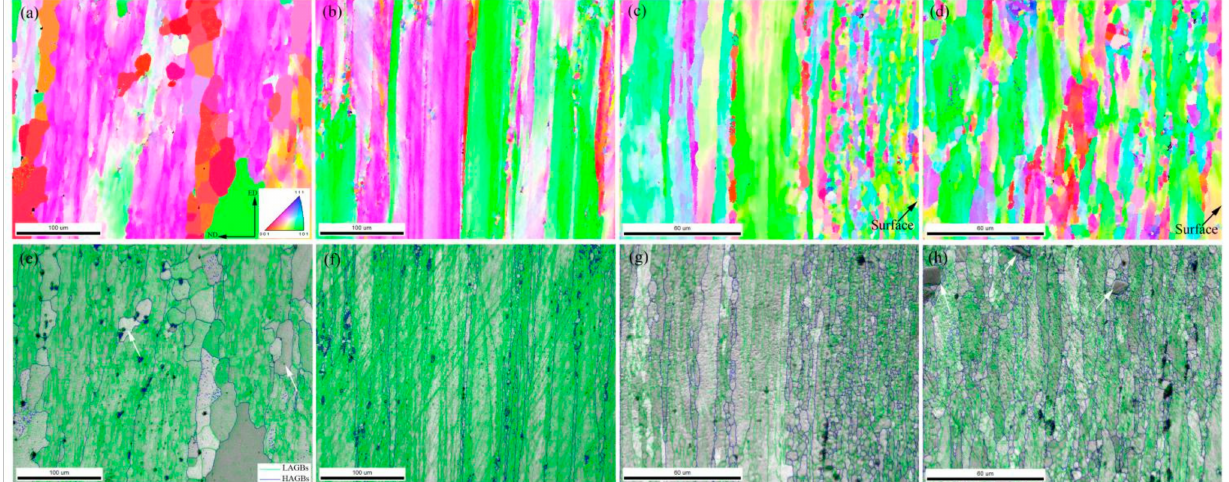
Figure 5. Grain orientation and grain boundary distribution maps of Al-Zn-Mg-Cu alloys after the solution treatment. ( a , e ) Al-Zn-Mg-Cu-Zr alloy in the central layer, ( b , f ) Al-Zn-Mg-Cu-Sc-Zr in the central layer, ( c , g ) Al-Zn-Mg-Cu-Zr alloy in